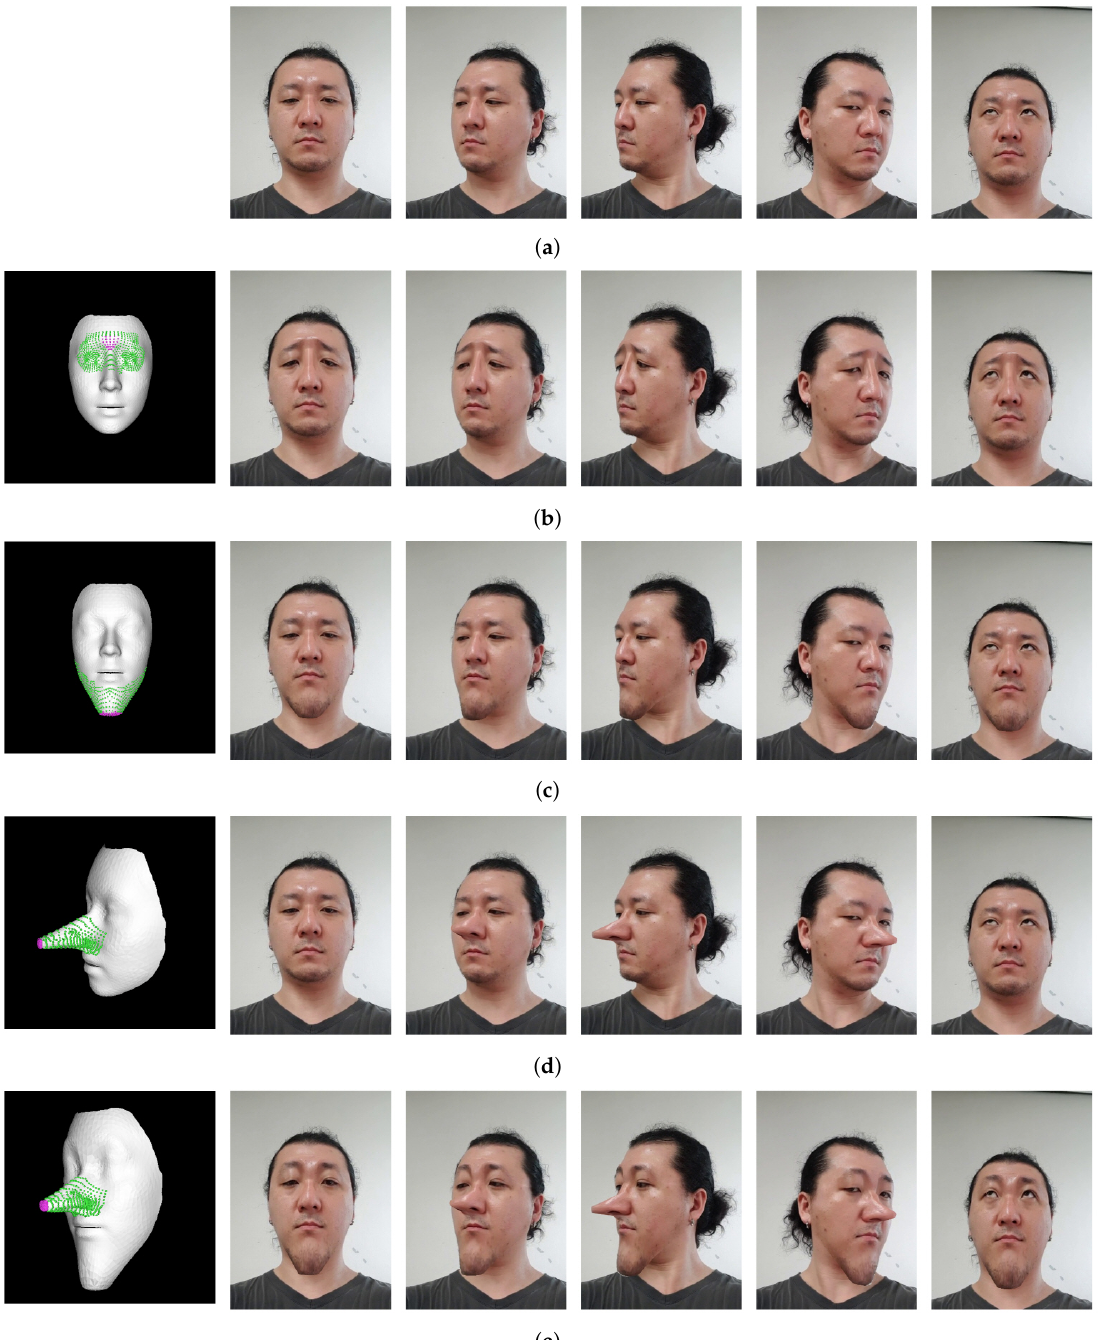
Figure 6. Results of face manipulation for video frames: ( a ) original frames; ( b – d ) results of manipulating specific parts of face; and ( e ) results of applying all manipulations in ( b – d